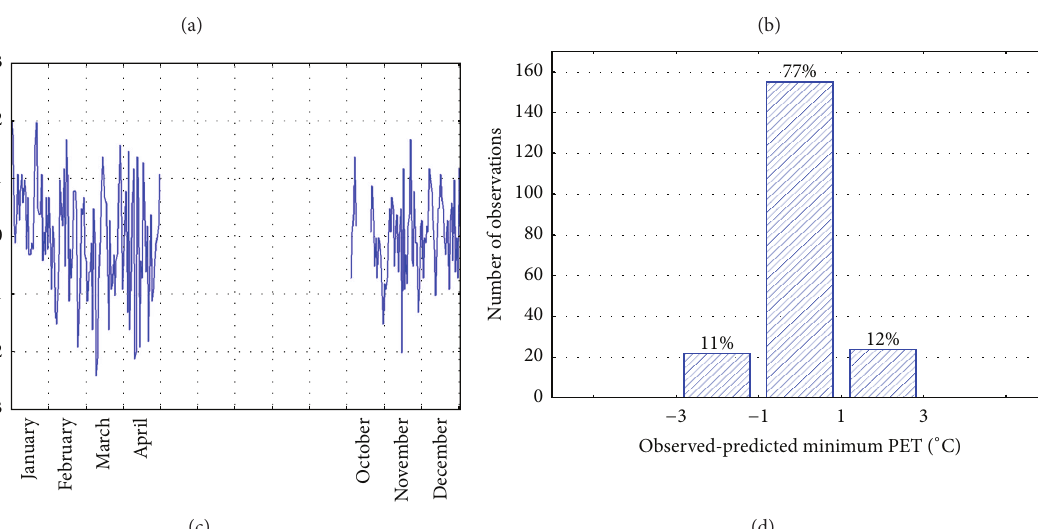
Figure 10: Observed versus predicted daily minimum PET values (a); scatter plot between observed versus predicted daily minimum PET values (b); observed minus predicted daily minimum PET values (c) and histogram with the absolute differences between the observed and the predicted daily minimum PET values (d). One day ahead prognosis. Cold period of 2011.